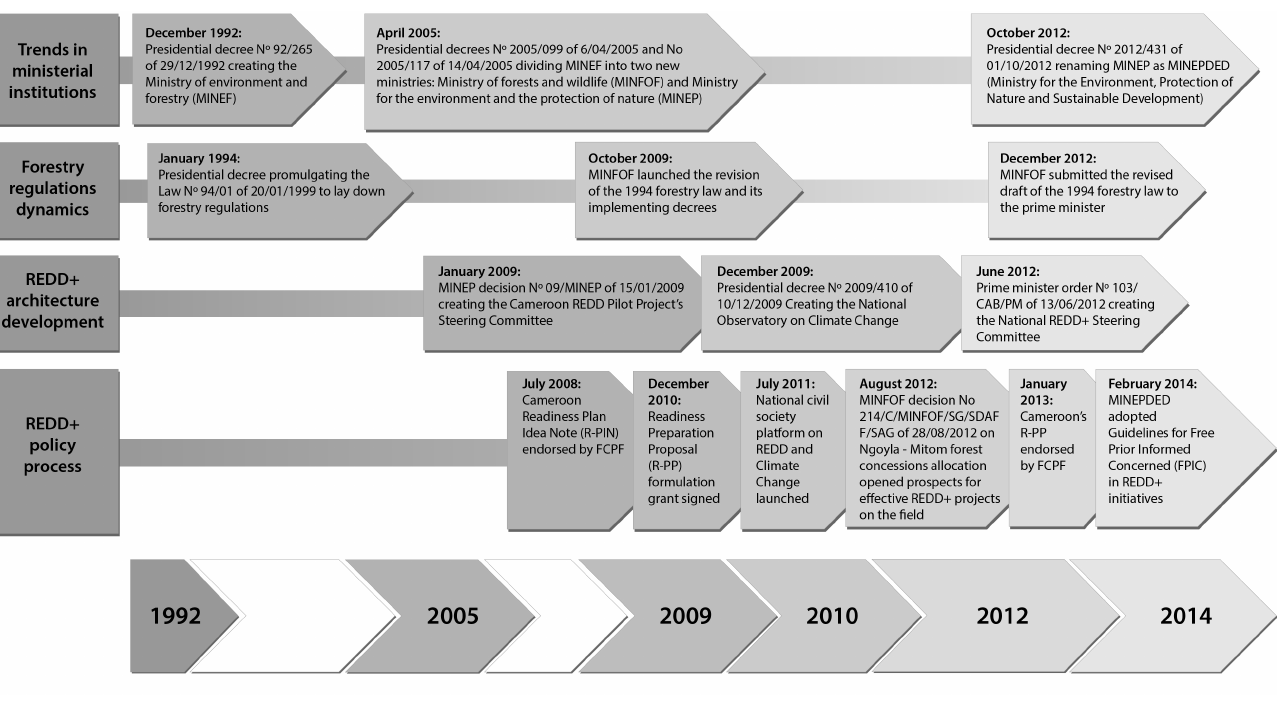
Fig. 1 . Key events related to forestry reforms and the REDD+ process in